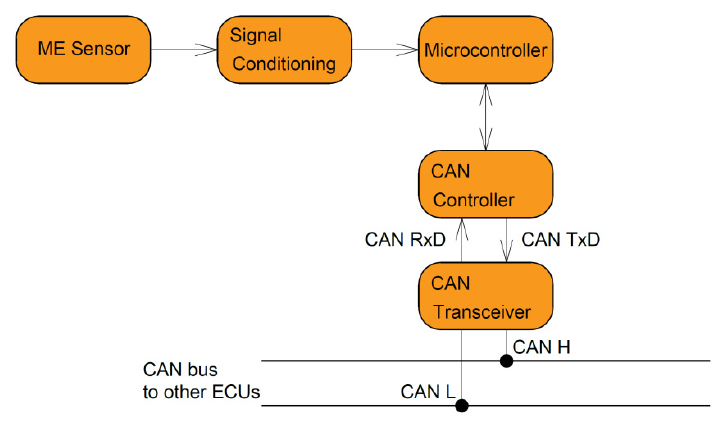
Figure 4. Schematic diagram of the signal processing.